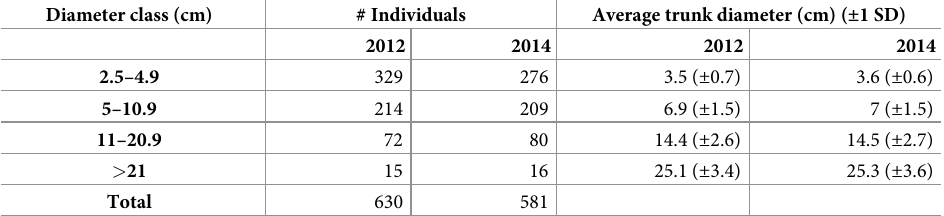
Table 1. Individuals distribution by diameter classes in 2012 and 2014 of the Yanacocha Reserve Andean forest plots (n =